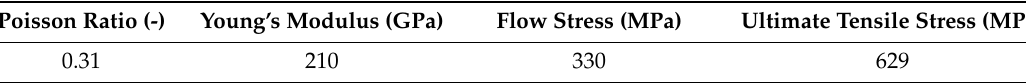
Table 1. The material properties of LZ50 steel.